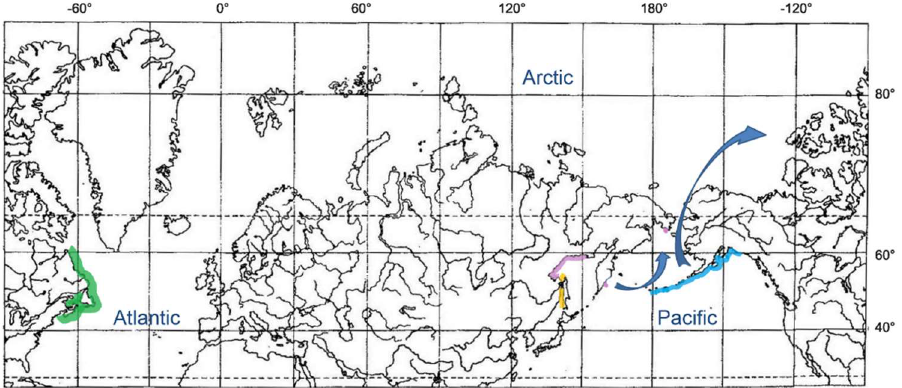
Figure 2. Distribution of “ L. atlanticus ” group in the Atlantic: green line— L. atlanticus ; in the Pacific: lilac line— L. shantarensis , yellow— L. schmidti , and blue— L. rutteri ; arrows show the most probable direction of the preglacial